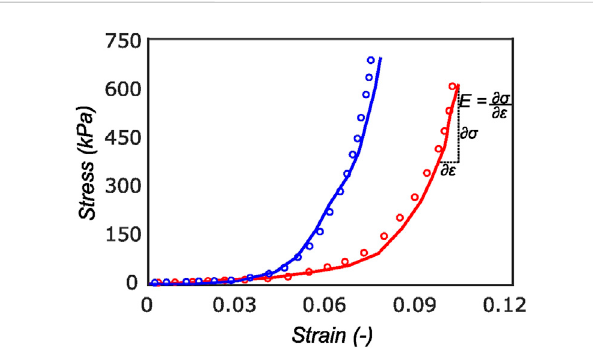
FIGURE 9 Cauchy stress versus strain for a sample in the radial (red curve) and circumferential direction (blue curve). The experimental data (solid curve) is well represented by the model (dotted curve) with r 2 of 0.94. On the fi nal loading regime of the red curve, the computation of linear elastic modulus is illustrated. Most of the tissue stiffness in this loading region is assumed to be contributed by fi bers.